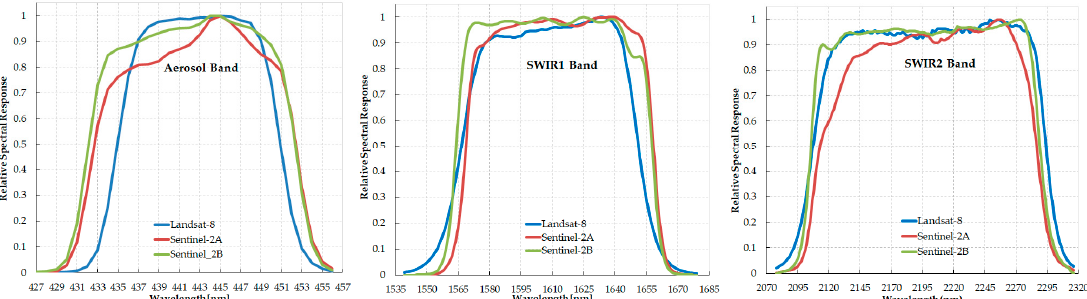
Figure 8. Relative spectral response curve at aerosol-band, SWIR-1 and SWIR-2 bands of Sentinel- 2A/2B and Landsat-8 Operational Land Imager (OLI). The data was accessed from https://landsat.gsfc.nasa.gov/preliminary-spectral-response-of-the-operational-land-imager-in-band- band-average-relative-spectral-response/